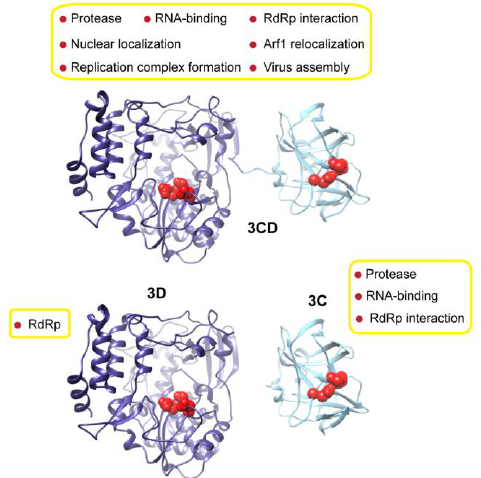
Figure 1. Crystal structure of 3CD is a composite of 3C and 3D proteins. Shown are the crystal structures of the precursor protein 3CD (PDB 2IJD) and the processed proteins 3D (1RA6, blue), and 3C (1L1N, cyan) proteins from poliovirus. The active-site residues of the protease (His-40, Glu-71, Cys-147) and polymerase (Asp-416, Asp-511, Asp-512, 3CD numbering) are shown as red spheres to indicate the relative orientation of the two domains. The different functions associated with the precursor and cleaved proteins are shown next to the structures.